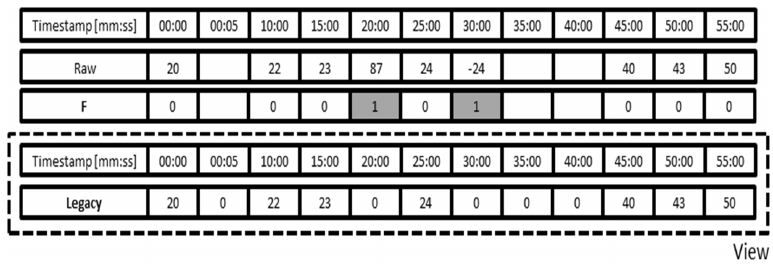
Figure 4. A view on the data for legacy system setting all faulty and missing data to zero.